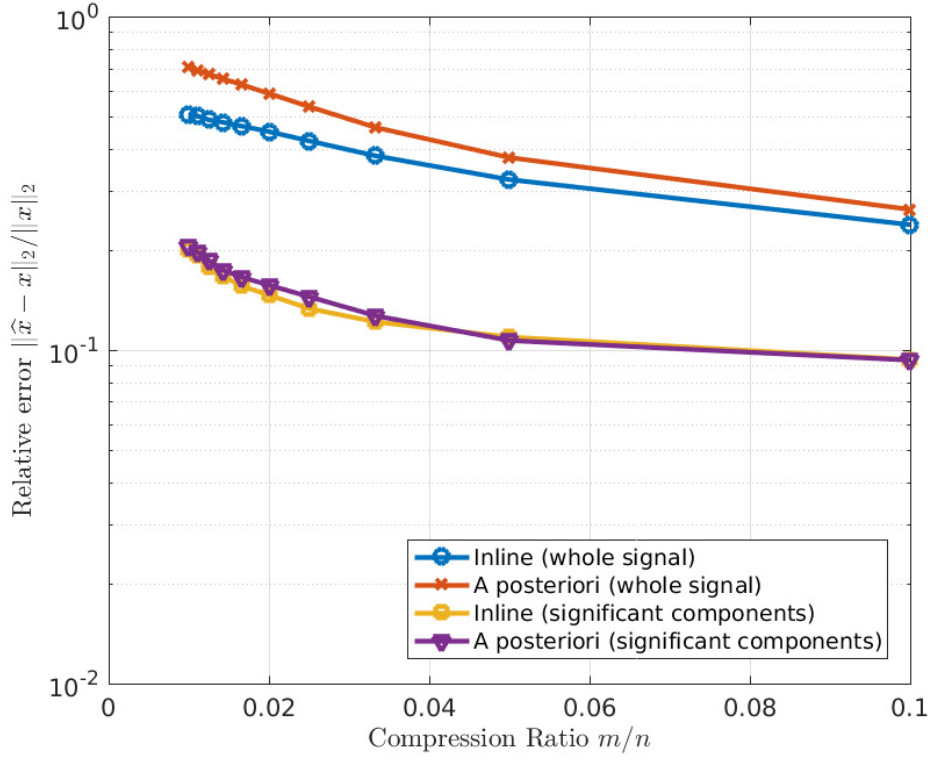
Figure 11. Image reconstruction: relative error as a function of relative number of measurements (CR).